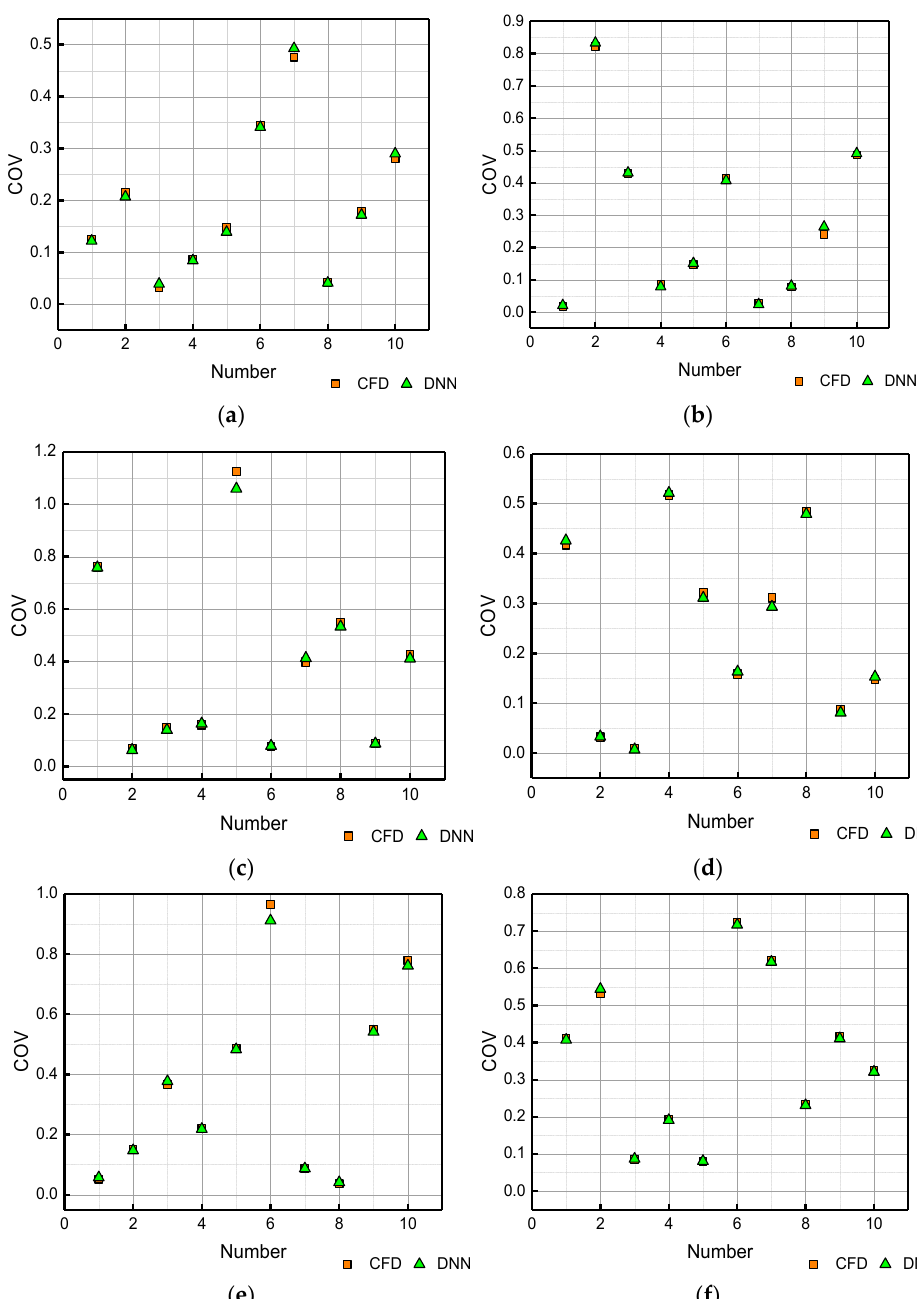
Figure 15. Comparison of COV predicted by DNN model with test sets by CFD simulations. ( a ) Test set 1. ( b ) Test set 2. ( c ) Test set 3. ( d ) Test set 4. ( e ) Test set 5. ( f ) Test set 6.